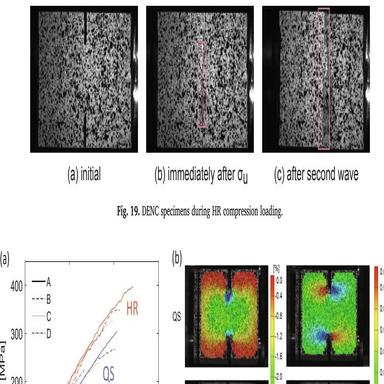
Bar strain wave group of a SHPB DENC test, and dynamic stress equilibrium check for specimens of sizes A (a and b) and D (c and d).